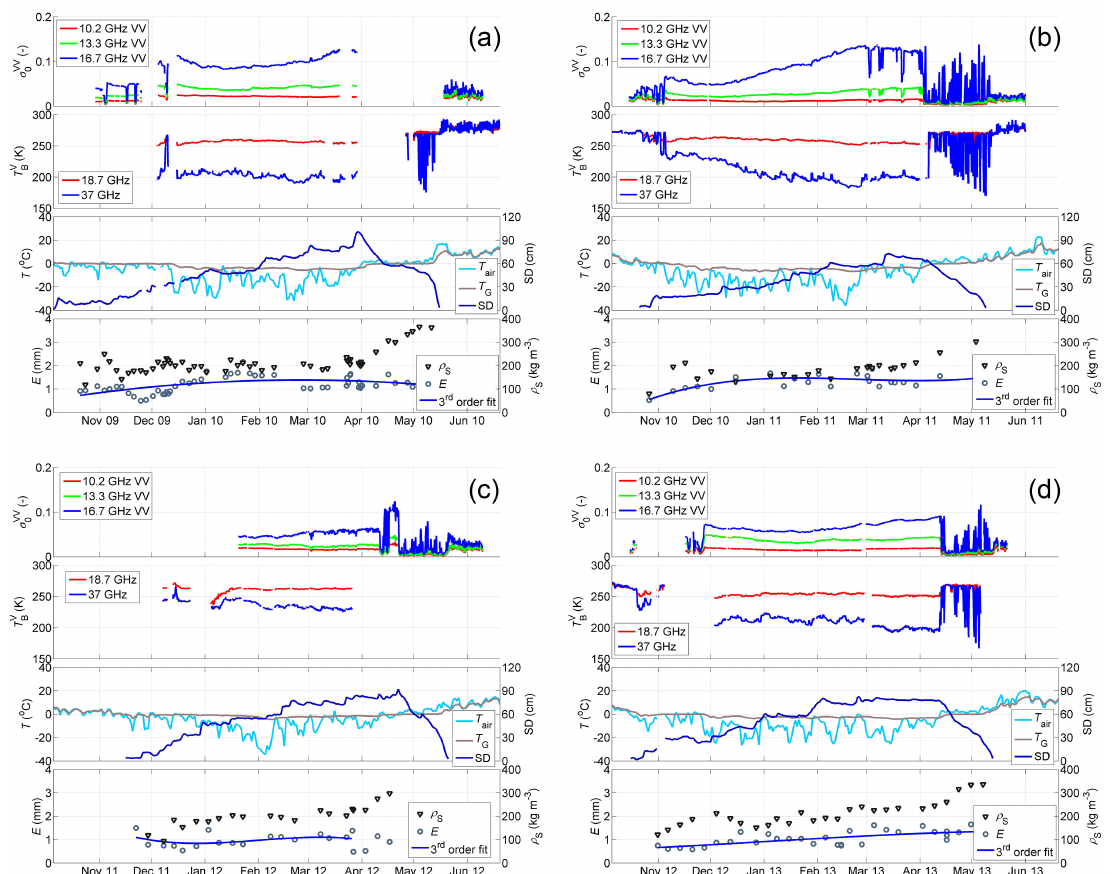
Figure 2. Summary of NoSREx seasons I–IV (a–d) . Panels from SnowScat VV-polarized backscattering 50 ◦ incidence angle; SodRad brightness temperatures at 18.7 and 37GHz, vertical polarization, 50 ◦ incidence angle; snow depth (SD), air temperature ( T air ) and ground temperature ( T G ); bulk averages of manually measured snow density ( ρ S ) and visual estimates of snow grain size ( E ). Third-order fit to time series of E